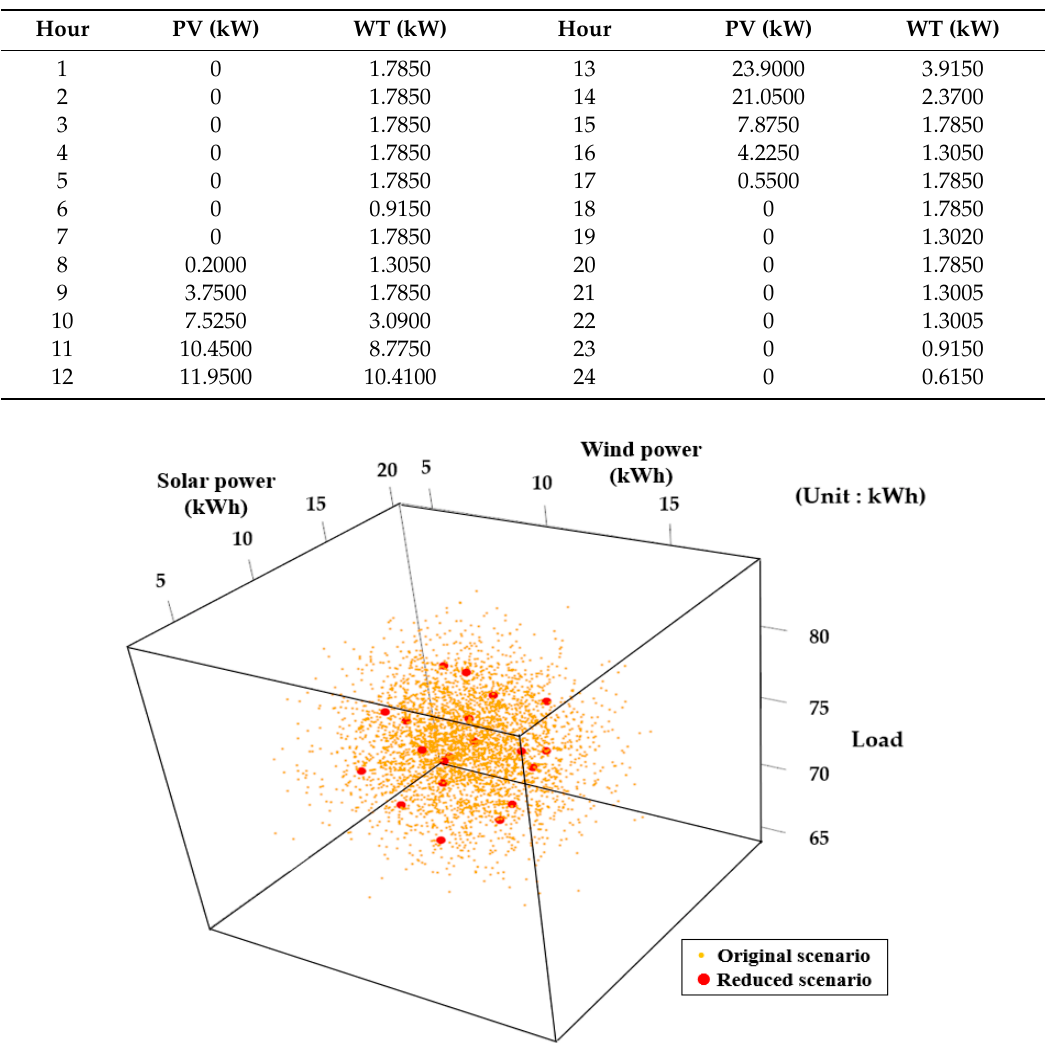
Table 4. Expected wind turbine (WT) and photovoltaic (PV) power.